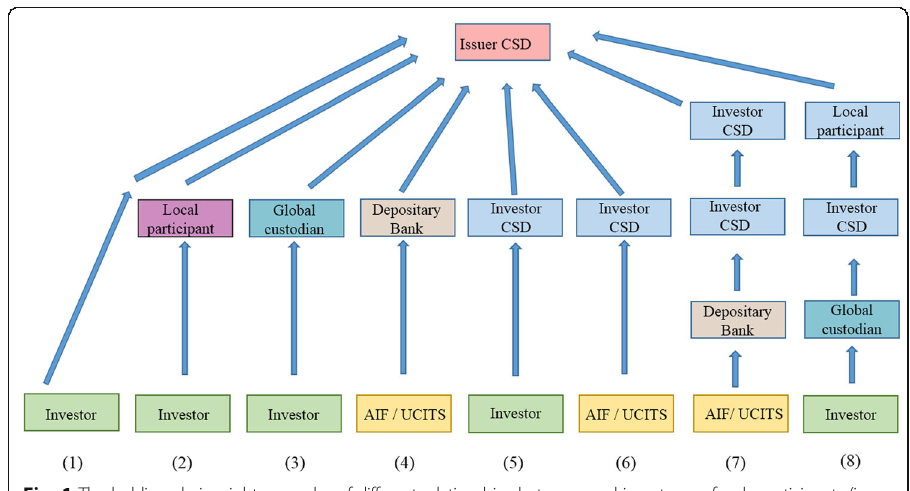
Fig. 1 The holding chain: eight examples of different relationships between end investors or funds, participants (i.e. local participants, global custodians, depository banks, and investor CSDs), and issuer CSDs. Source: Priem